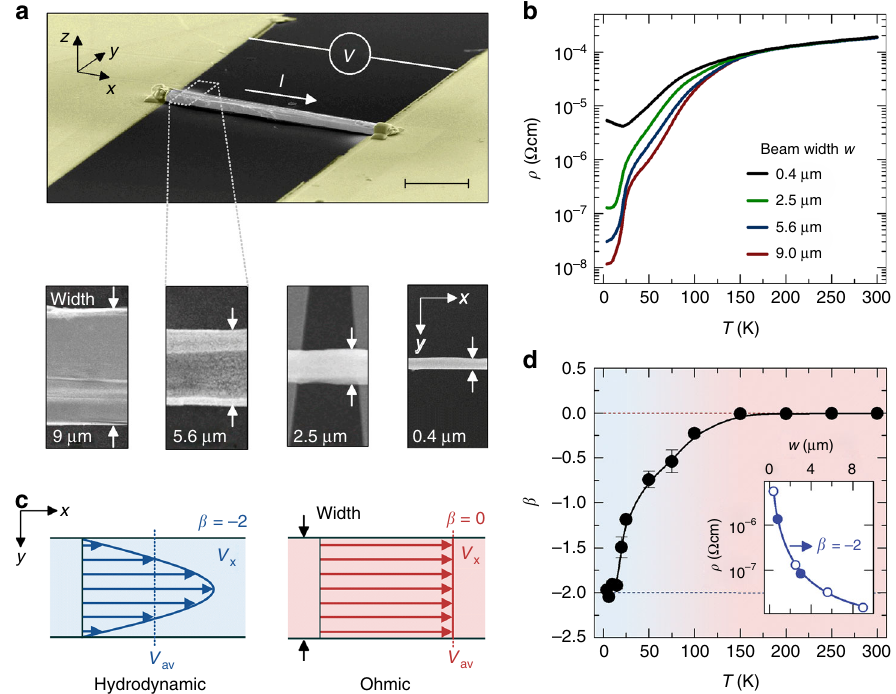
Fig. 1 Effect of the channel width on the electrical resistivity. a False-colored scanning electron-beam microscopy (SEM) image of the device to measure the electrical resistance R = V / I (upper panel) of the WP 2 micro-ribbons, where I is the applied current and V the measured voltage. x , y , and z are the spatial dimensions. The scale bar denotes 10 μ m. Ribbons of four different widths w were investigated (lower panels). The error of the measured width is below 5%, including the uncertainty of the SEM and sample roughness. b Temperature ( T )-dependent electrical resistivity ρ of the four ribbons. c Sketch of the velocity v x fl ow pro fi le for a Stokes fl ow (left panel, blue line and narrows) and conventional charge fl ow (right panel, red line and arrows). v av is the average velocity of the charge-carrier system. β is the exponent of the functional dependence ρ ( w ) = ρ 0 + ρ 1 w β . d β as a function of T , extracted from power-law fi ts of the data plotted in b . The error bars denote the errors of the fi ts. The inset shows a power-law fi t at 4 K, where the open and fi lled symbols represent quasi-four and four-terminal measurements, respectively. The line is a power-law fi t, leading to β = − 2. The colored background marks the hydrodynamic (light blue) and the normal metallic (Ohmic) temperature regime (light